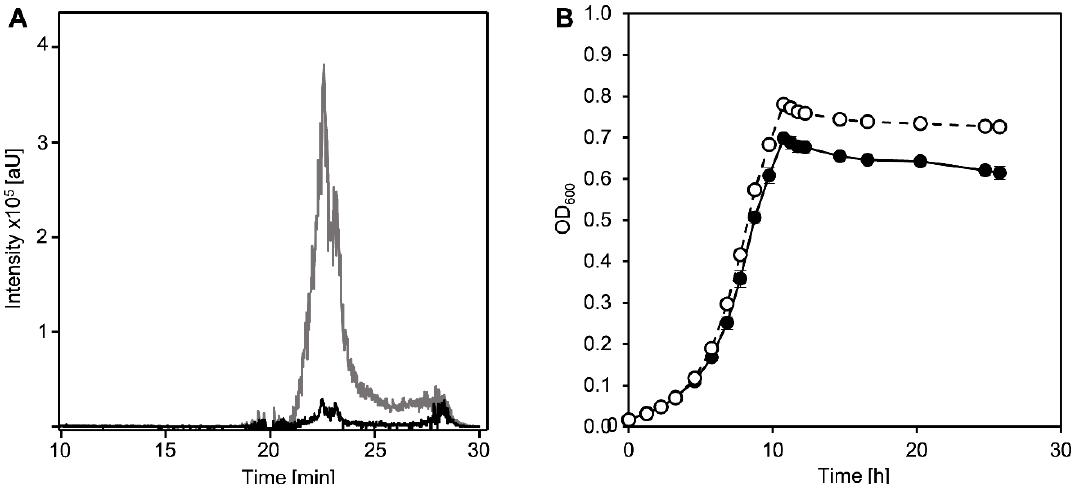
Figure 2. ( A ) Detection of DHSATD (XI) in supernatants of cultures of Sphingobium sp. strain Chol11 wt (black line) and the deletion mutant Sphingobium sp. strain Chol11 Δ nov2c349 (gray line) during growth with cholate after 5.7 h of incubation. HPLC-MS data are displayed as extracted ion chromatogram at negative ion mode of MS ( m / z value of DHSATD ([M-H] −1 = 313 Da)).( B ) Growth of Sphingobium sp. strain Chol11 wt (filled circles) and Sphingobium sp. strain Chol11 Δ nov2c349 (open circles) with 1 mM cholate (I in Figure 1) as sole carbon source. Error bars indicate standard deviation, which may not be visible if too small ( n = 3).